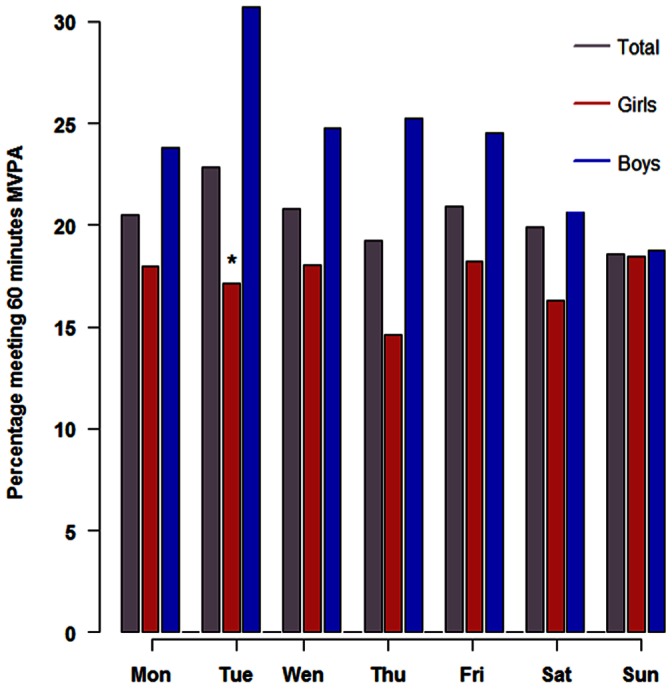
Percentage of girls and boys with at least 60 minutes of MVPA according to weekday (Mon-Sun).Differences between days were not significant in boys and of borderline significance in girls (p<0.054). *Significant differences between boys and girls, p = 0.02.